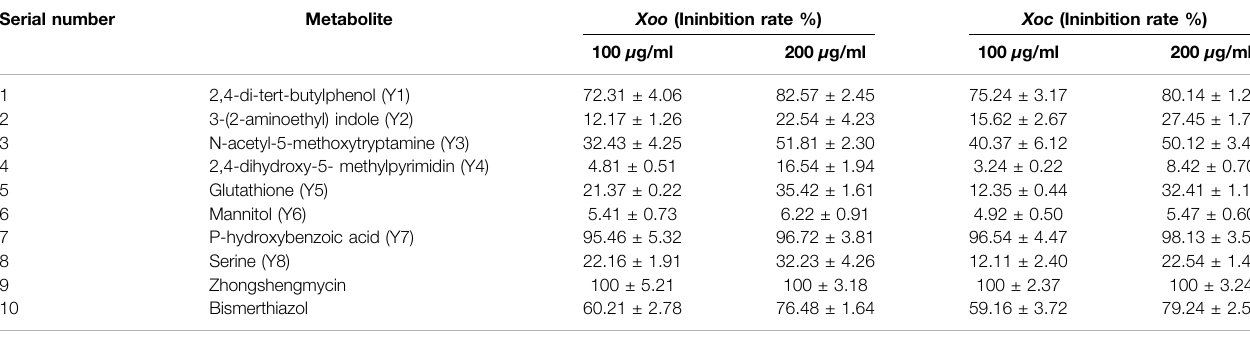
TABLE 1 | In vitro antibacterial activity of metabolites and positive control drugs against Xoo and Xoc . Serial number